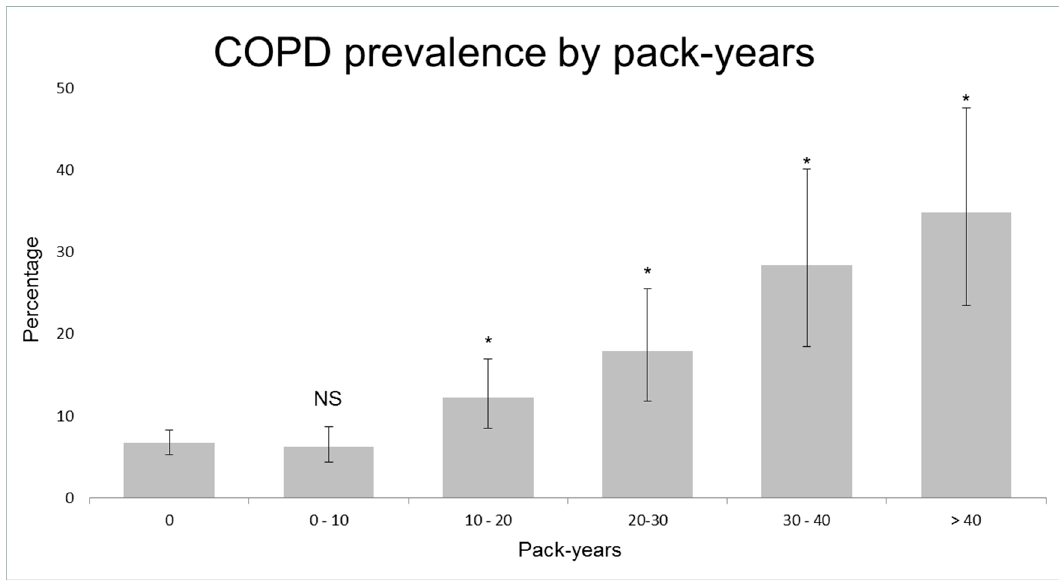
Figure 3. Prevalence of Chronic Obstructive Pulmonary Disease (COPD) according to pack-years. NS = not significant; * = p < 0.05 compared to subjects that have never smoked.